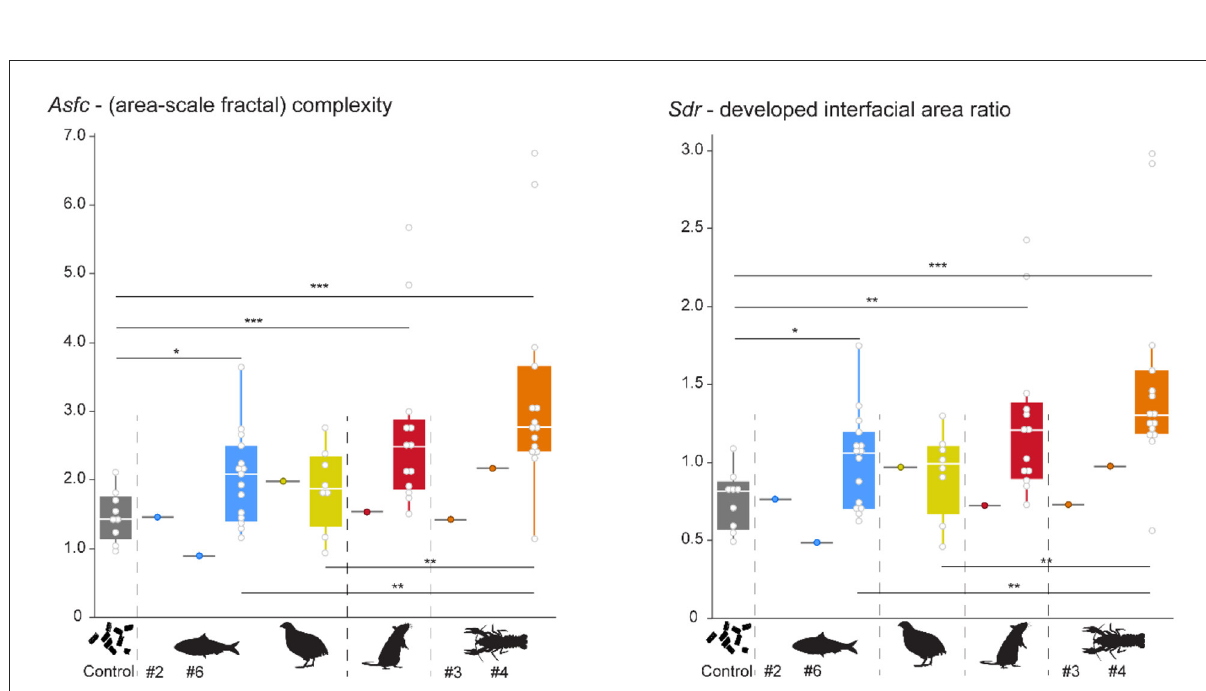
FIGURE4 Pooled Asfc and Sdr observed for all diets over the whole experimental duration. Significance level: * = 0.05, ** = 0.01, *** = 0.001. Sardine = blue, quail = yellow, rat = red, crawfish = orange. Gray boxplots with colored points indicate that teeth were collected before the start of the feeding experiments, while the alligator was still feeding on pellets. Pooled data were created by using the median from all scans per tooth, and then calculating a mean per collection date. Each collection date represents one